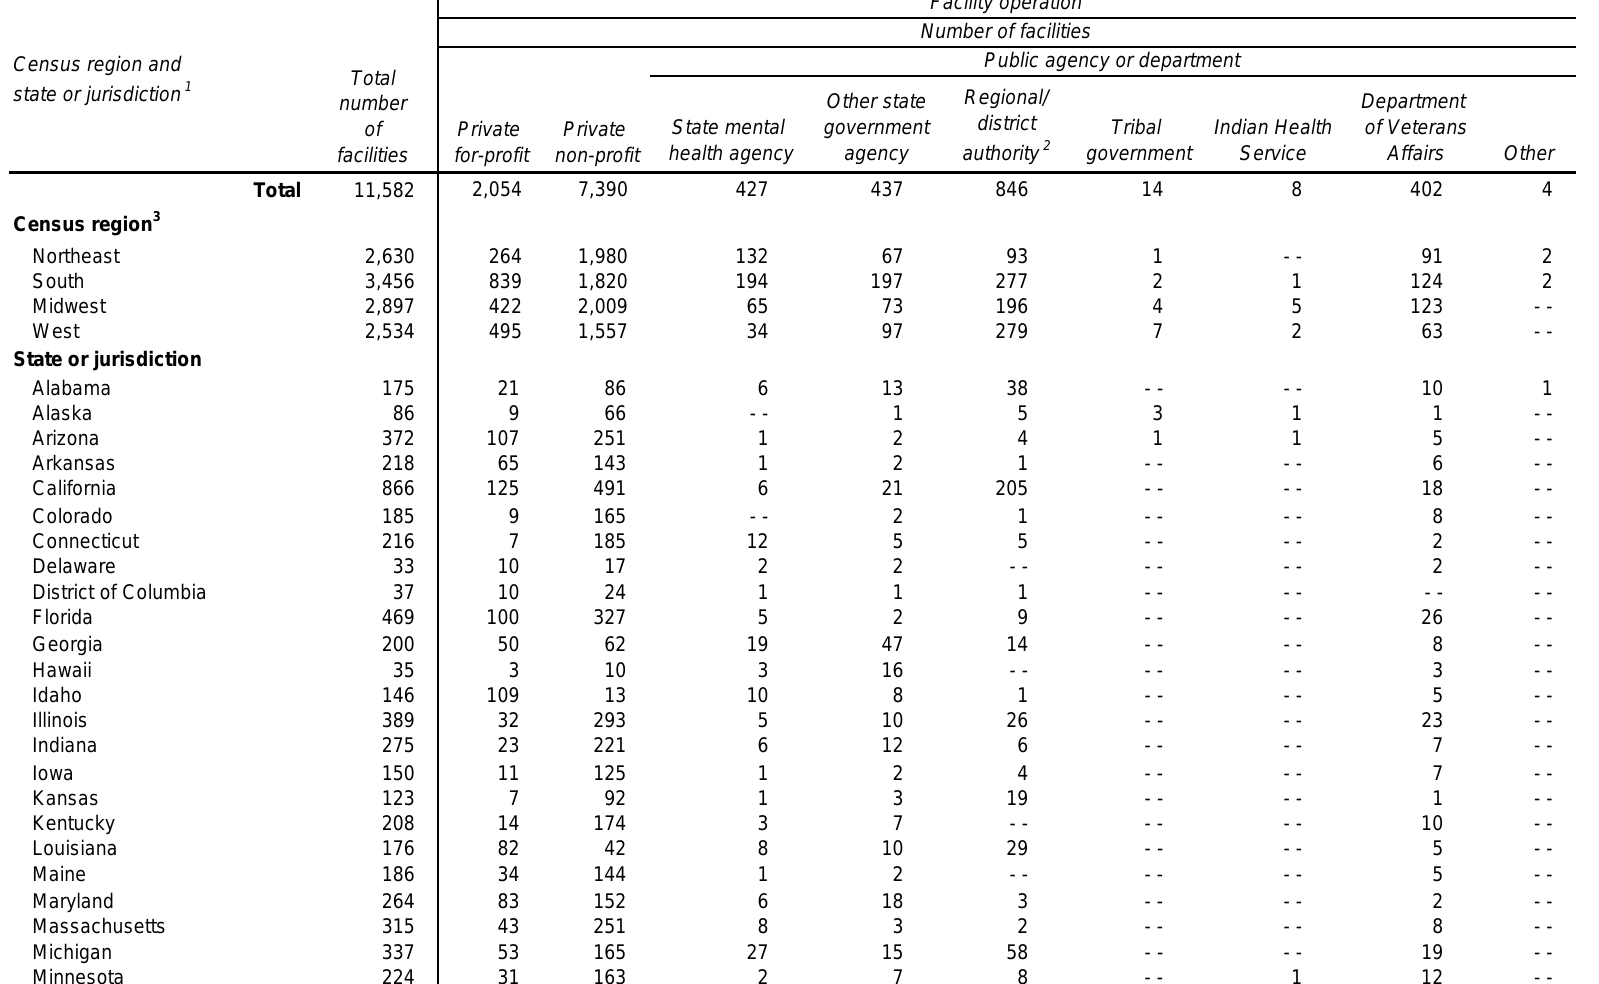
Table 3.2a. Mental health treatment facilities, by facility operation, Census region, and state or jurisdiction: Number, 2017